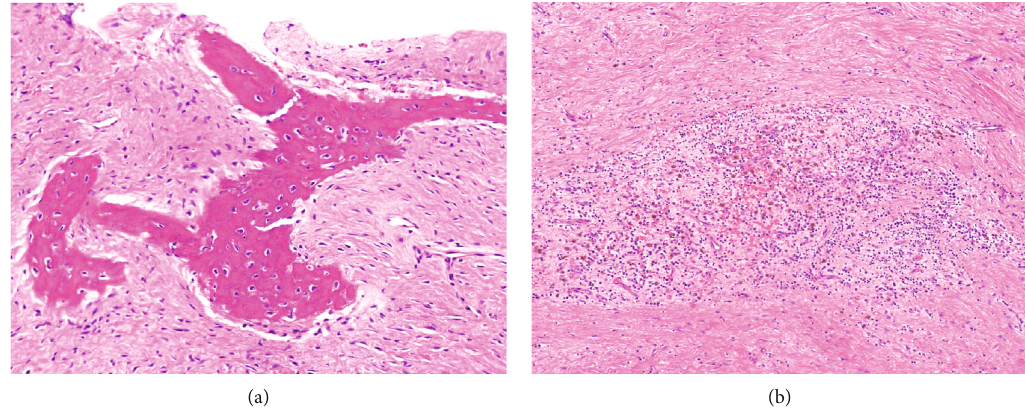
Figure 4: Surgical specimen. (a) A characteristic pattern of disconnected, bizarrely contoured dysplastic trabeculae enmeshed in primitive mesenchymal cells (hematoxylin and eosin, × 200). (b) Granulation tissue can be observed in the mesenchymal stroma (hematoxylin and eosin, × 100).